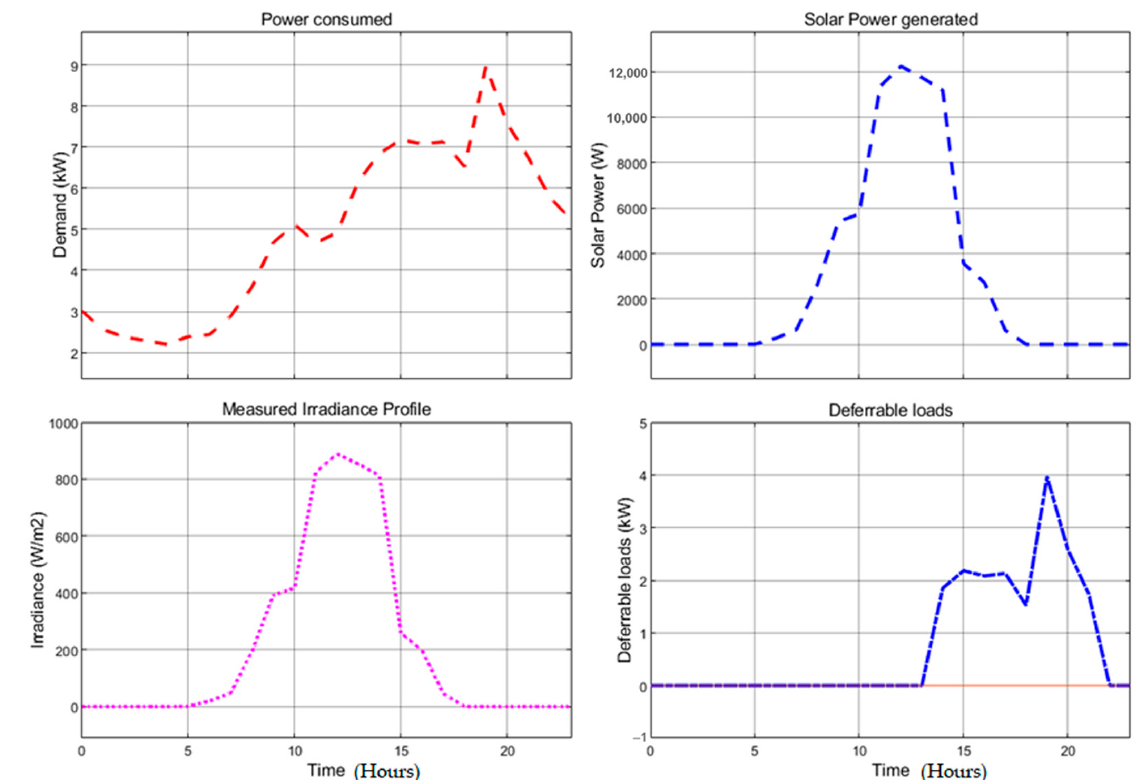
Figure 17. Simulink measurement results before the application of DSM in Bunjako Island.